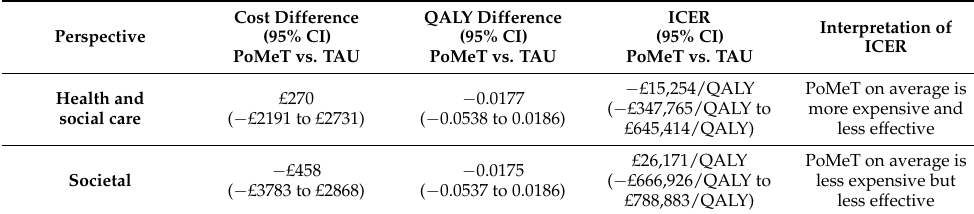
Table 4. Cost-effectiveness results (PoMeT vs. TAU).